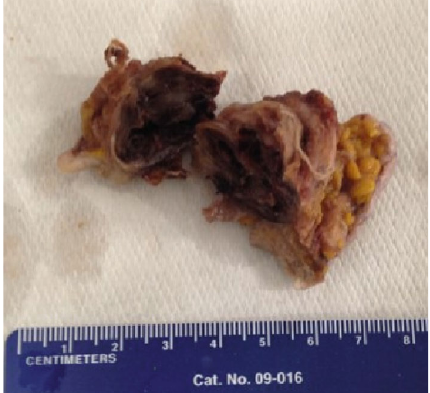
Figure 4: Mass removed from the patient ’ s hip comprised of soft tissue, hemorrhage, and aseptic foreign body